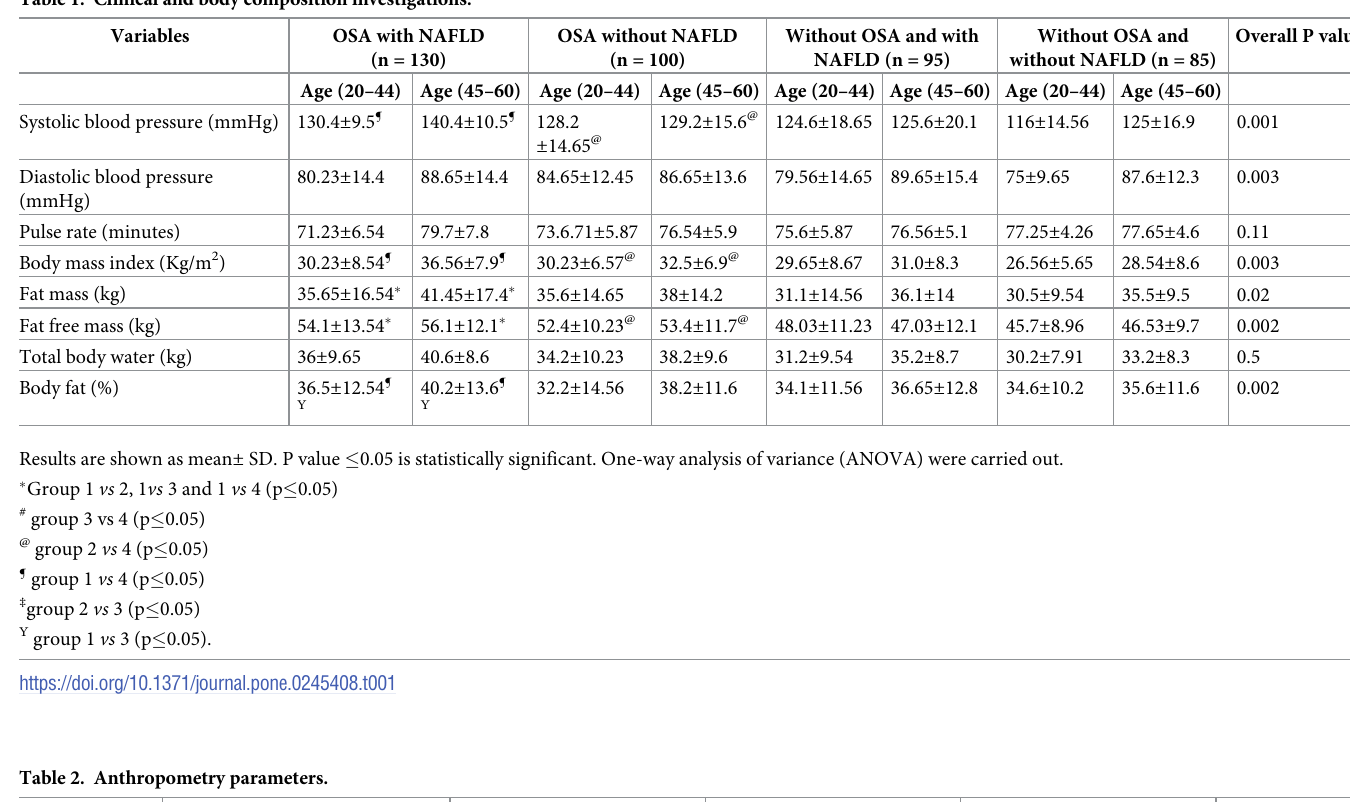
Table 1. Clinical and body composition investigations.